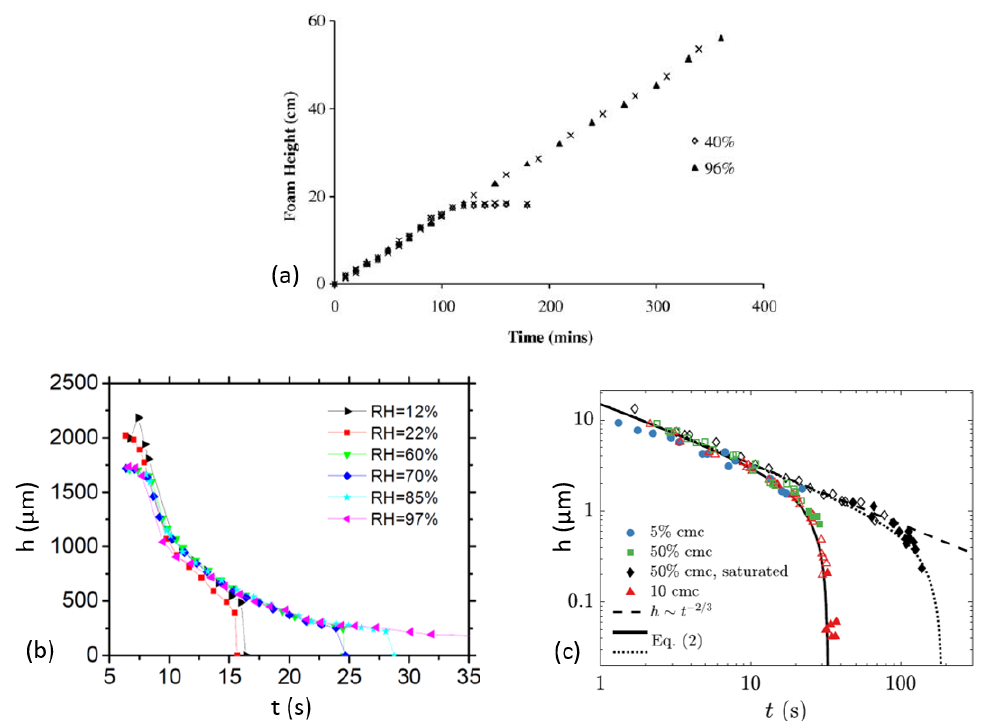
Figure 6. Representative experiments of thin films stability with controlled humidity. ( a ) Extracted with authorization from Li et al. [54]. Foam height as a function of time in a cylindrical column which height is 55 cm between the liquid interface in the absence of foam and a humidity sensor. The bottom of the column is immersed in a 2.92 g L − 1 SDS aqueous solution, where a constant bubbling produces the foam. The relative humidity at the top of the column is controlled. Cross symbols represent repeat of experiments. ( b ) Extracted with authorization from Champougny et al. [55]. Thickness evolution 1 mm below the superior frontier of a thin film extracted at 0.5 mm s − 1 from a 5 cmc TTAB solution. The h = 0 nm points correspond to the instant when the film rupture is detected. ( c ) Extracted with authorization from Poulain et al. [45]. Film thickness evolution of surface bubbles with R = 5.2 ± 0.4 mm in solutions of TTAB of concentration 0.05, 0.5 and 10 times de cmc. The unsaturated experiments are performed in ambient conditions i.e., RH = 26% while the saturated ones are about RH = 96%. The continuous and dotted lines are the solutions of the integration of Equation (10), respectively with RH = 26% and RH = 96% The thickness measurements are operated through Taylor-Culick velocity measurements at burst. Filled symbols represent spontaneous burst events while open ones are obtained through manual bursts with a